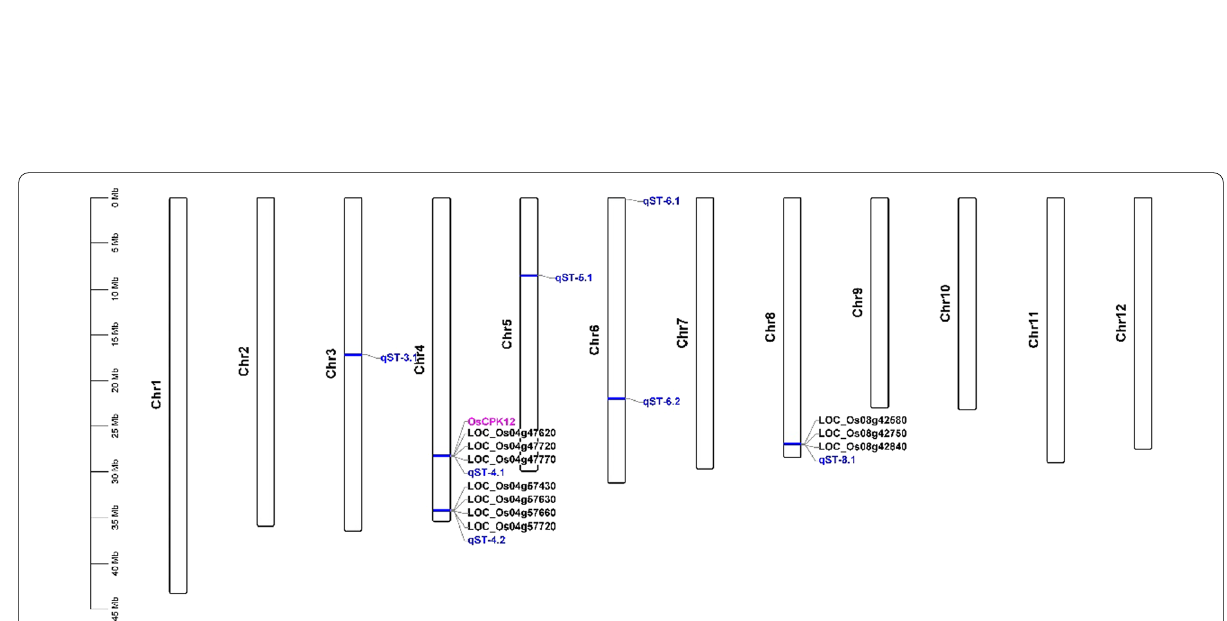
Fig. 6 Known genes and their homologous genes in our QTLs. Note Red represents known genes that fall into QTLs, and black represents homologous genes of known genes in